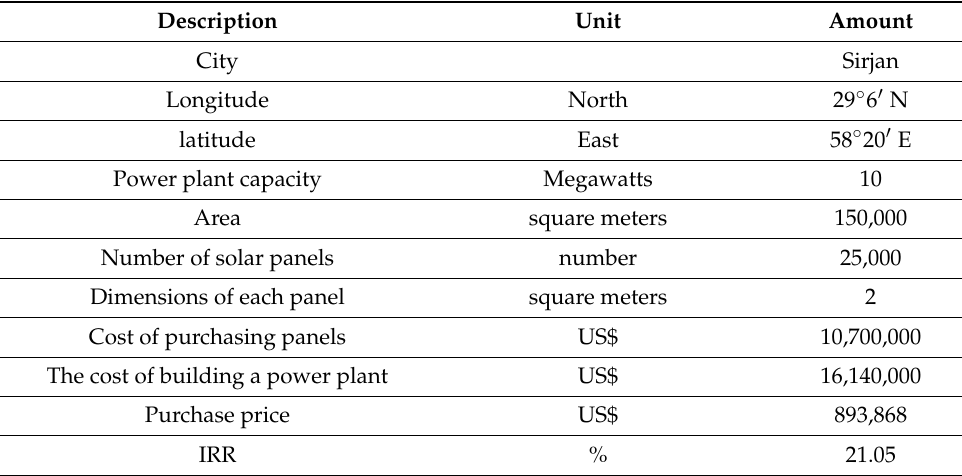
Table 8. Design information of a 10 MW solar power plant in Sirjan.